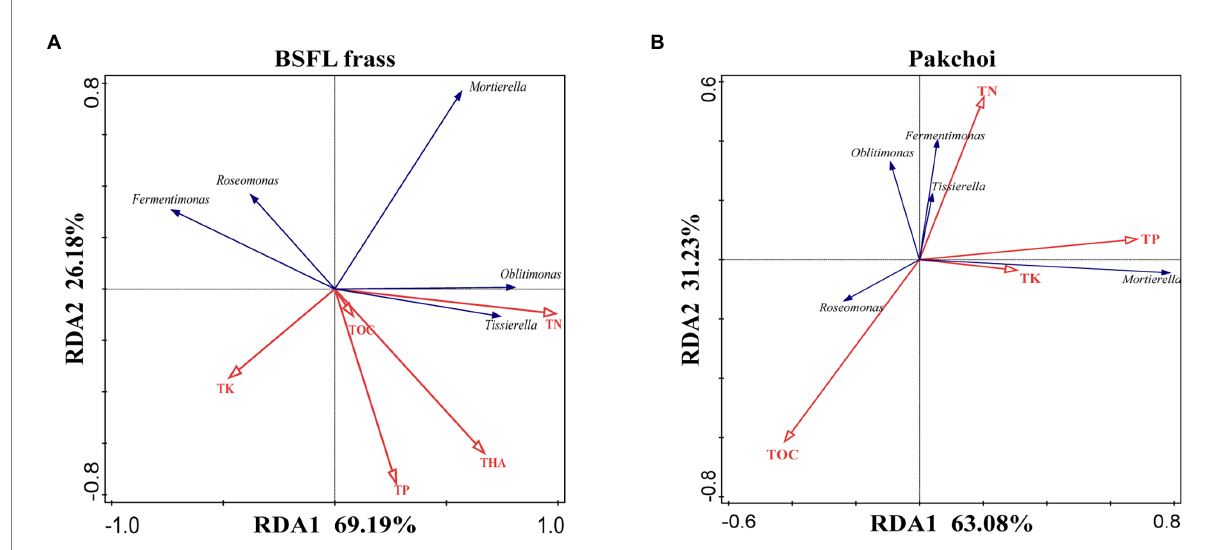
FIGURE 6 Redundancy analysis (RDA) of the potential host microorganism ( Oblitimonas , Tissierella, Mortierella , Fermentimonas , and Roseomonas ) patterns of BSFL frass (A) and pakchoi (B) using chemical properties as explanatory